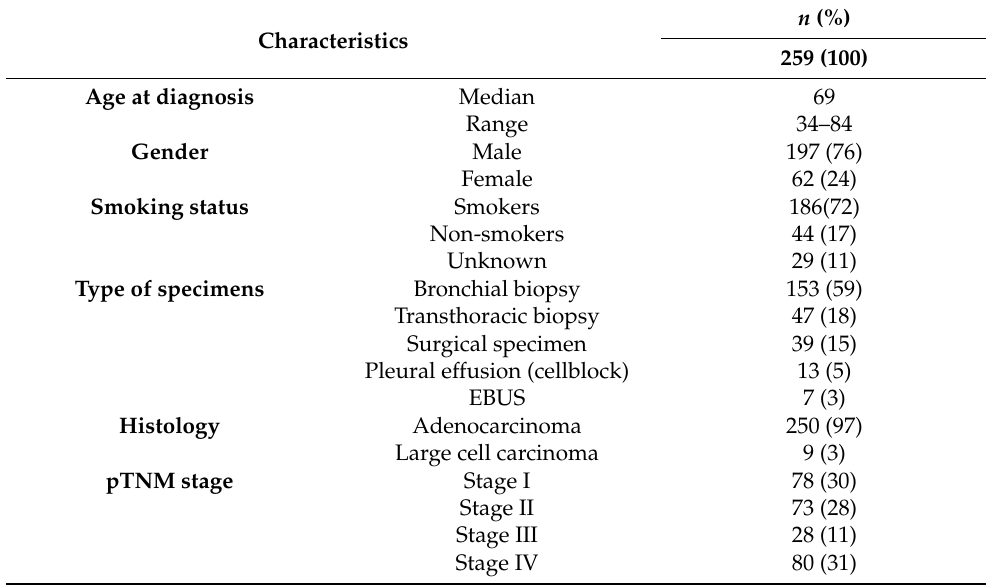
Table 1. Main epidemiological and clinico-pathological features of the study population. EBUS: en- dobronchial